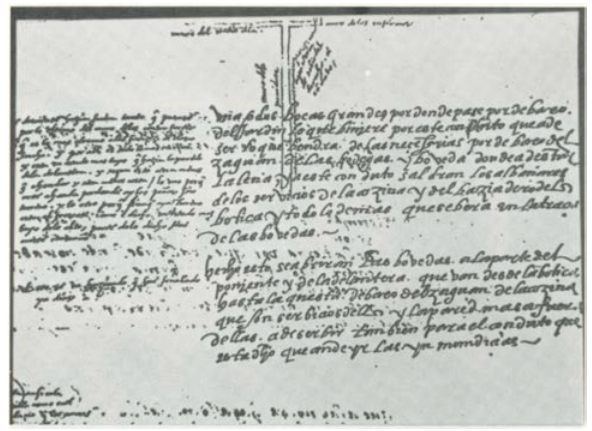
Figure 1. Juan Bautista de Toledo 1564, sketch of the drainage tunnel under the Galería de Convalecientes on top of a letter to King Philipp II. Archivo General de Simancas (Valladolid, Spain).